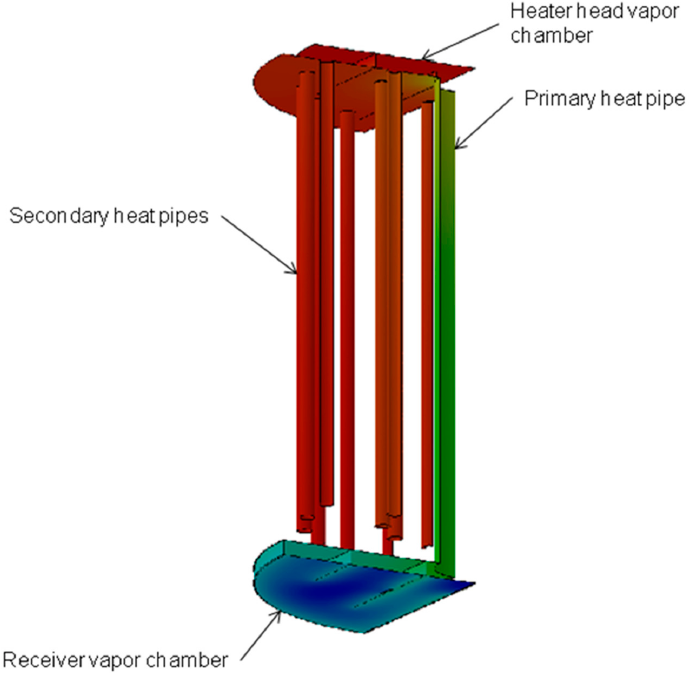
Figure 5. Wick finite element method (FEM) Analysis.